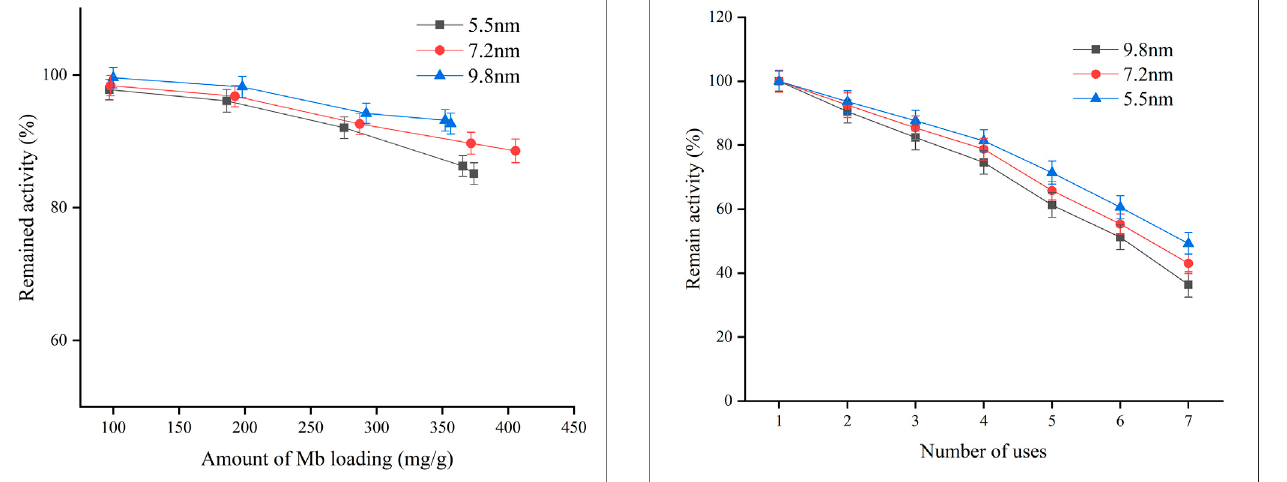
FIGURE 2 | Effect of pore size and amount of Mb loading on remained activity.